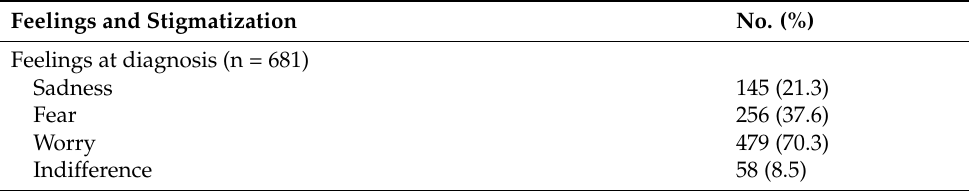
Table 4. Emotional reaction linked to infection with SARS-CoV-2 in notified cases in the first pandemic